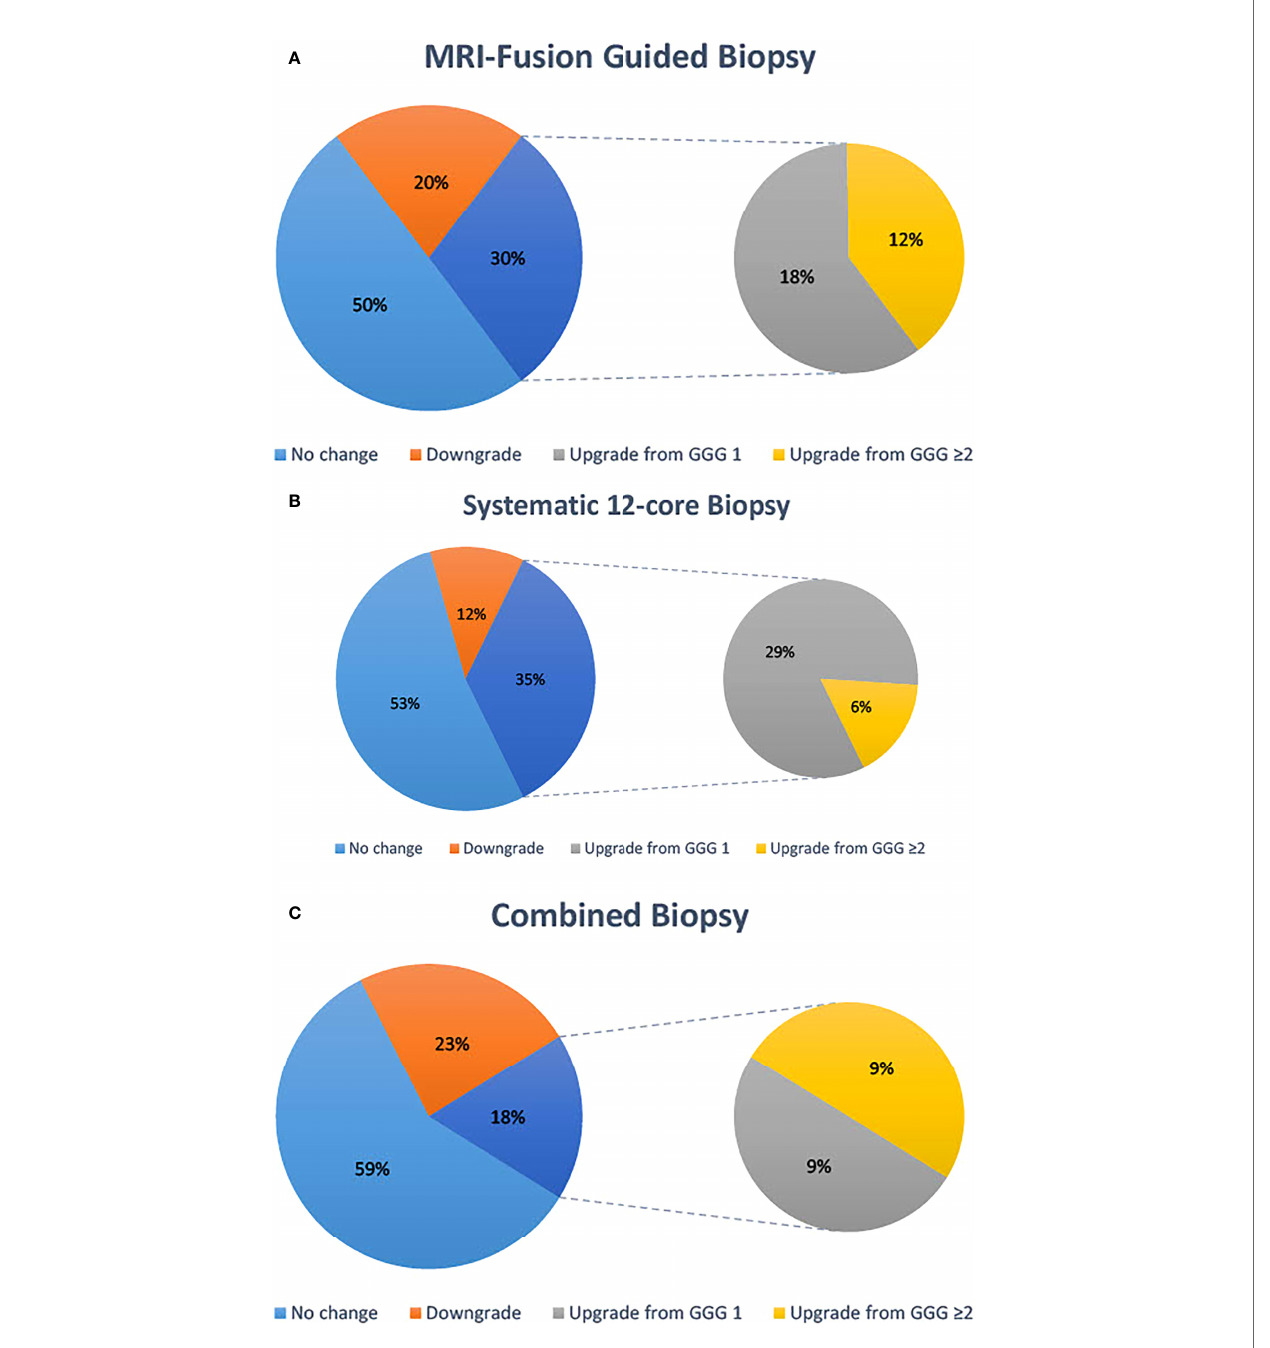
FIGURE 1 | Concordance of highest Gleason score on biopsy with Gleason score reported on prostatectomy specimens. Data are reported for MRI-fusion guided biopsy (A) , systematic 12-core biopsy (B) and a combined biopsy approach (C)